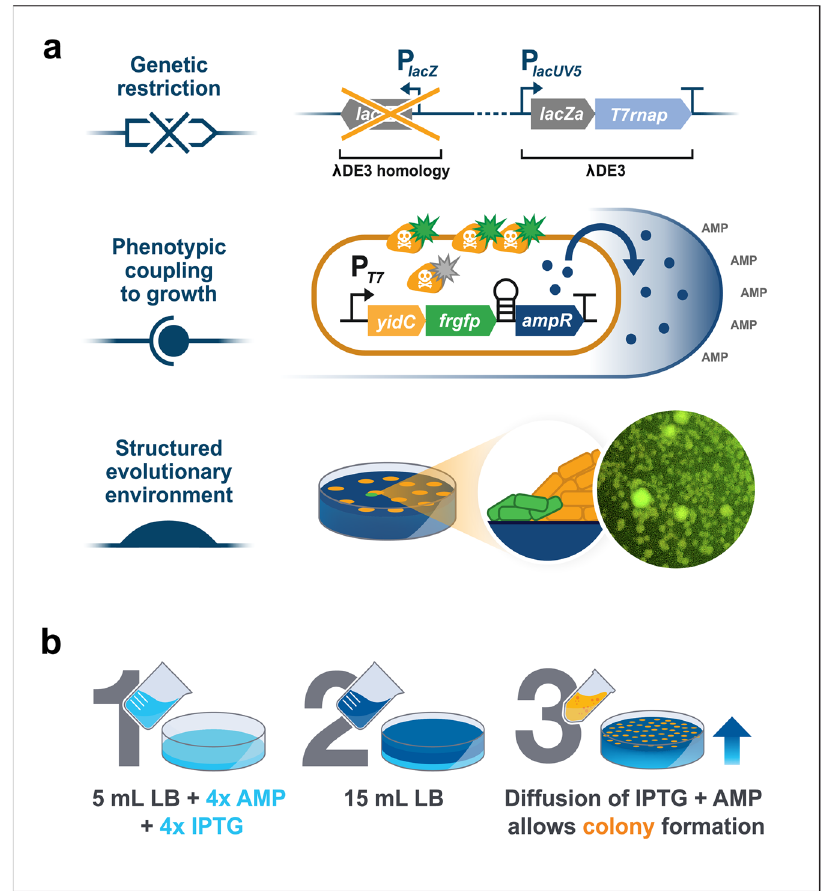
Fig. 1 Evolution strategy to isolate mutations conferring tolerance towards toxic proteins in E. coli BL21(DE3). a Illustration showing the experimental set-up used to restrict the evolutionary space for BL21(DE3) to overcome protein production toxicity on three levels: (upper panel) genetic restriction was accomplished by deleting a part of the BL21(DE3) genome that frequently recombines and lowers the T7 RNAP expression, (middle panel) protein production was coupled to both fl uorescence and antibiotic resistance to prevent the formation of non-producing mutants and (lower panel) a spatiotemporally structured environment of ageing bacterial colonies was designed in order to identify strong phenotypic mutants. b Schematic of the work fl ow to produce layered agar plates that allow diffusion of the antibiotic ampicillin (AMP) and the inducer IPTG to allow suf fi cient time for colony formation on the surface of the top agar layer before toxic protein production is